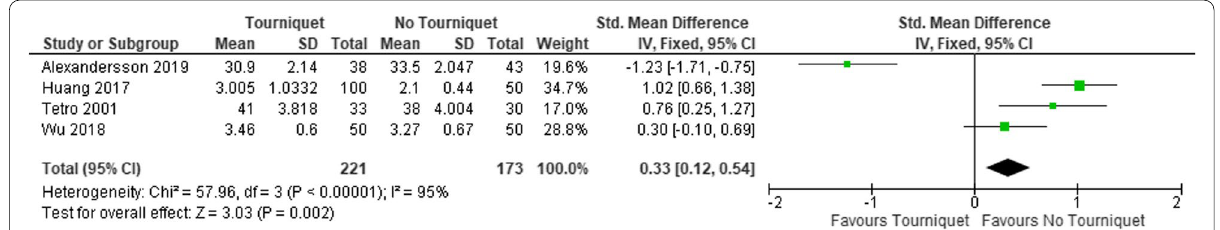
CI Confidence interval, OR Odd ratio, T Tourniquet group, NT No tourniquet group